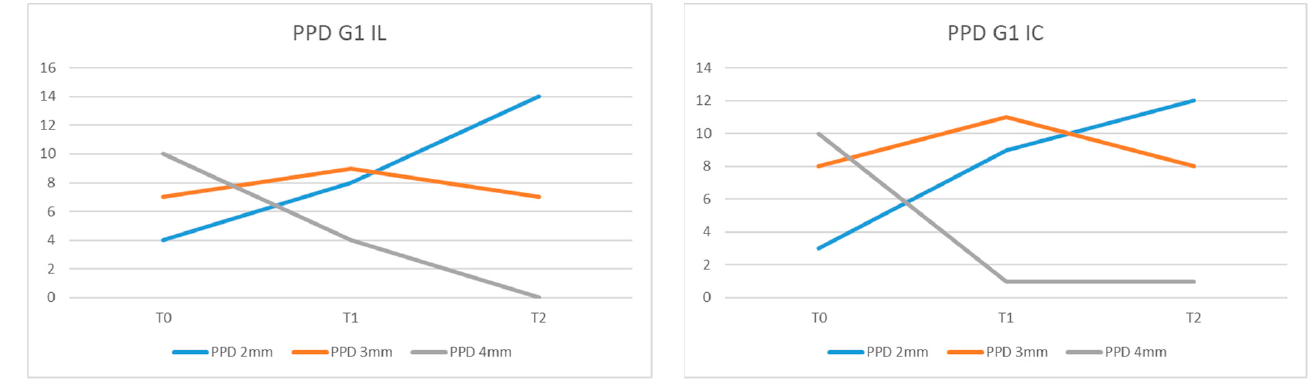
Figure 5. PPD values in G2 at moments T0 and T2 .